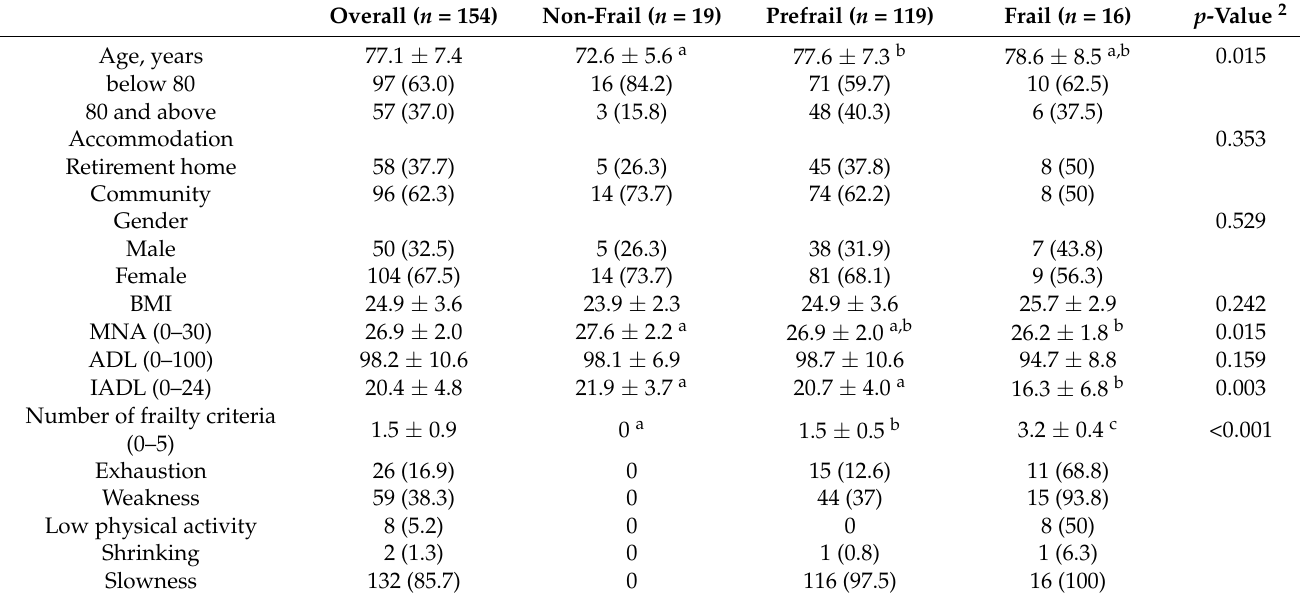
Table 2. Characteristics of overall participants and across frailty status 1 .